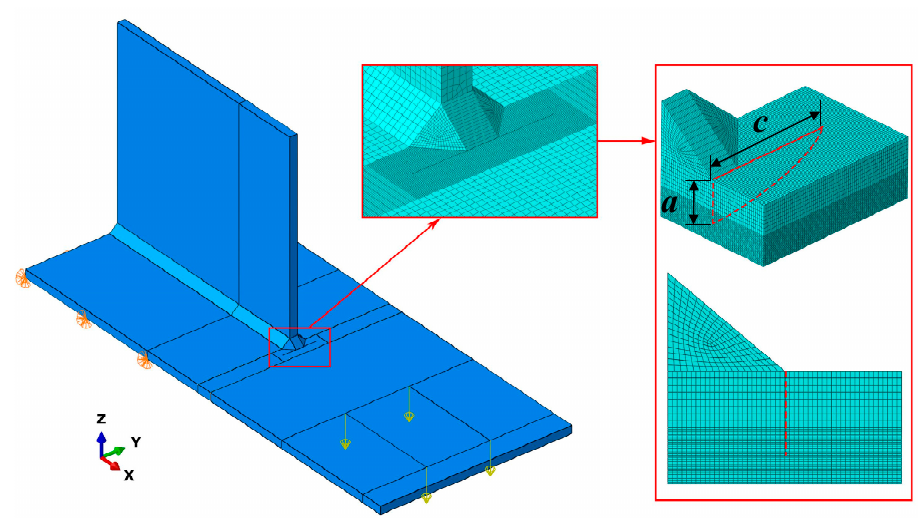
Figure 16. XFEM model.